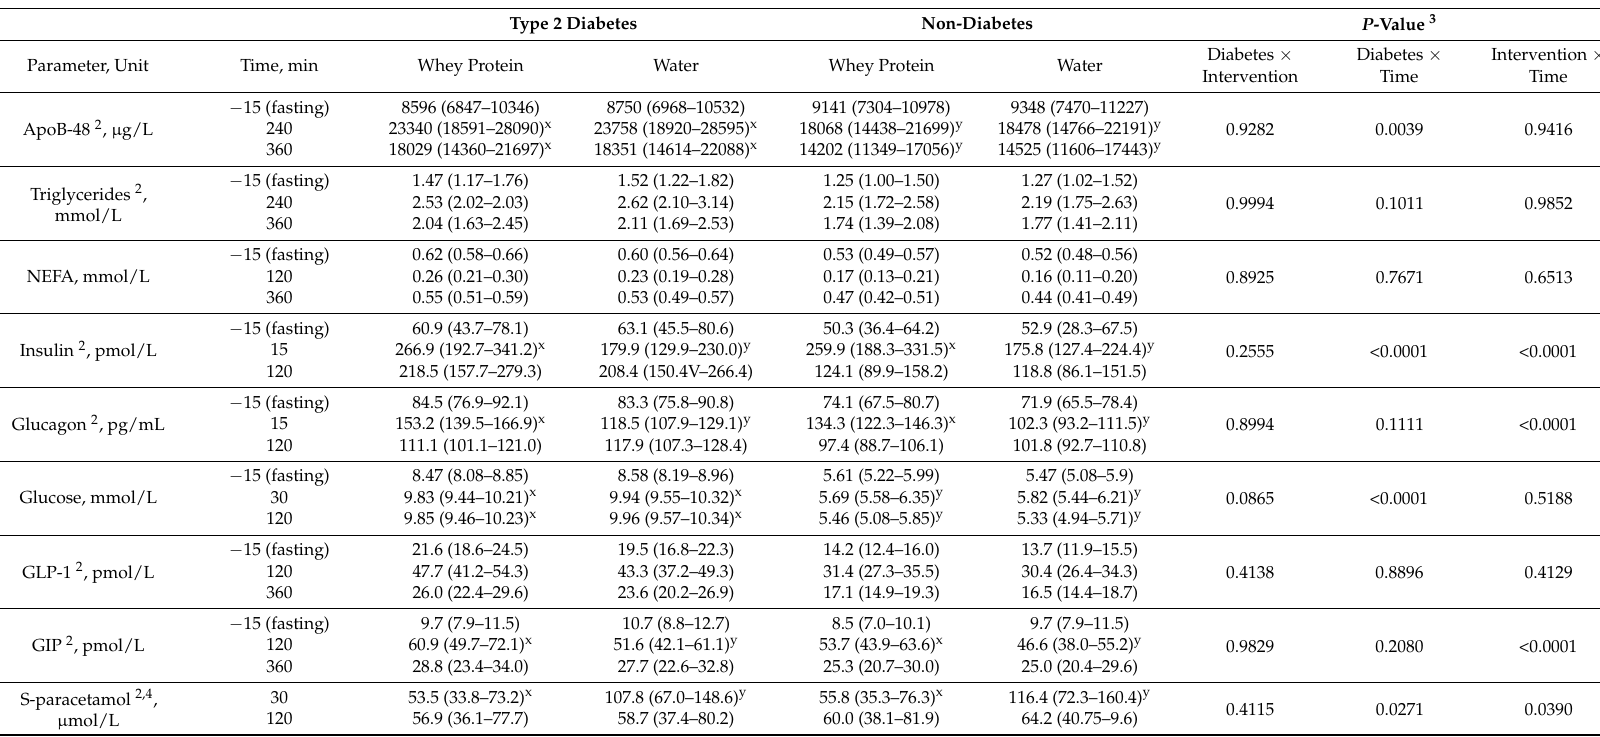
Table 2. Postprandial concentrations (95%-CI) to selected time points of biochemical parameters during the postprandial period. Subjects with ( n = 12) and without type 2 diabetes (T2D) ( n = 12) 1 were observed for 360 min after consumption of a pre-meal of whey proteins or water before a fat-rich main